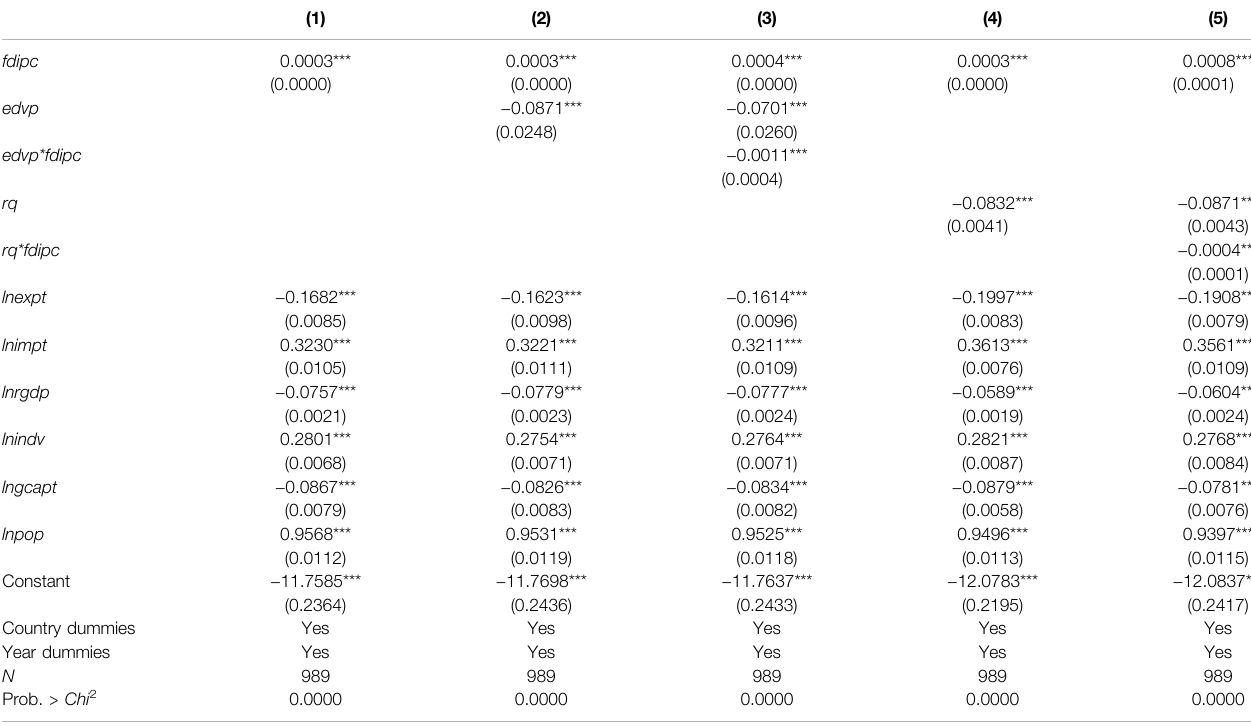
TABLE 4 | Results of moderating effects from economic development and regulatory quality.